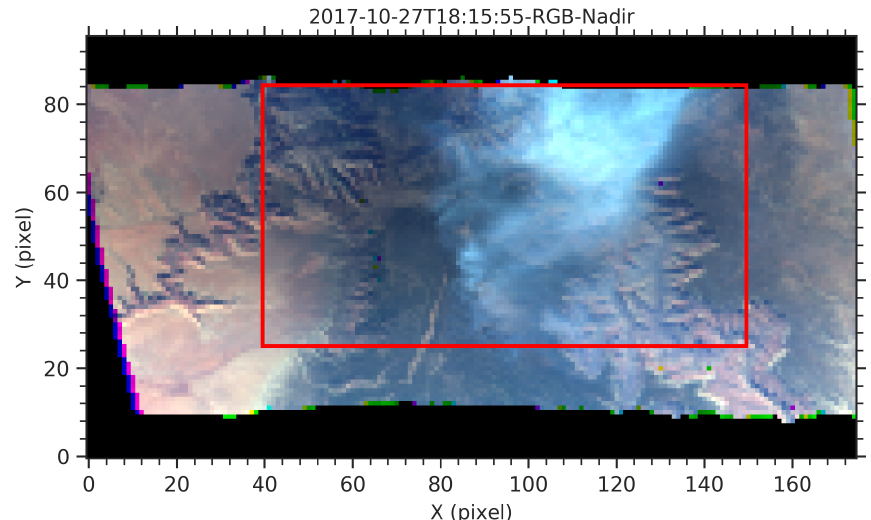
Figure 8. RGB composite image of the 27 October 2017 T18:16UTC smoke scene; X and Y axes are the number of pixels (550m × 550m) along the respective axes. Pixels inside the red rectangular box are used for the aerosol retrievals of AOD, SSA, RRI, and IRI. These are plotted in Fig.